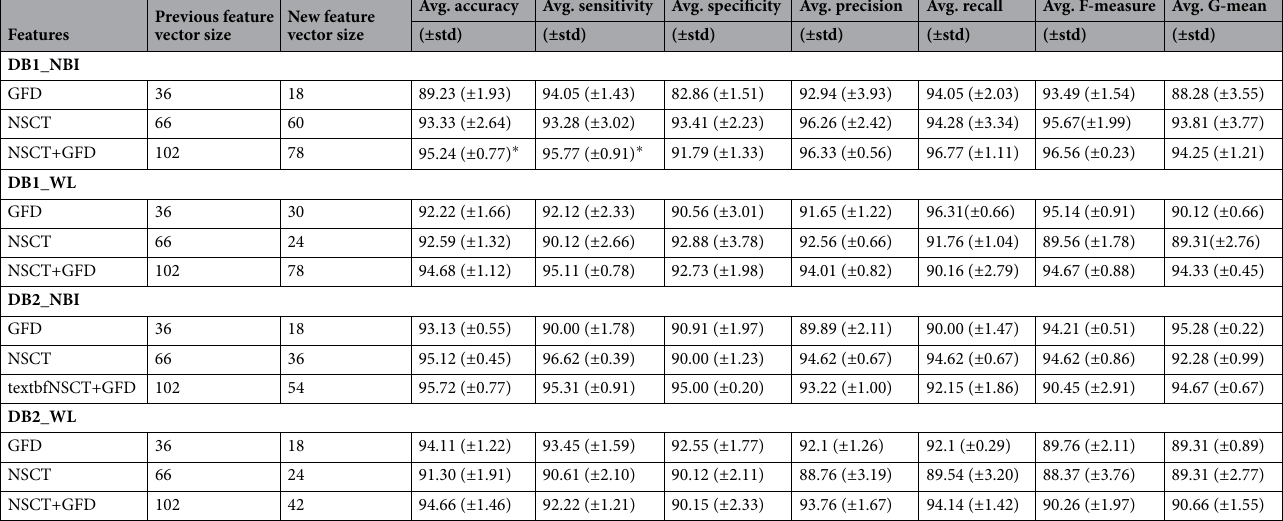
Table 3. Results of final classification for three different feature vectors used.